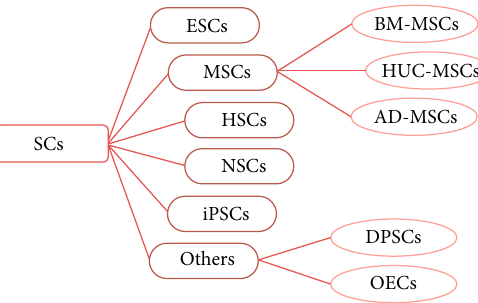
Figure 1: The common stem cell (SC) types for the treatment of spinal cord injury (SCI), including embryonic stem cells (ESCs), mesenchymal stem cells (MSCs), hematopoietic stem cells (HSCs), neural stem cells (NSCs), induced pluripotent stem cells (iPSCs), dental pulp stem cells (DPSCs), and olfactory ensheathing cells (OECs). MSCs consist of bone marrow mesenchymal stem cells (BM-MSCs), human umbilical cord-mesenchymal stem cells (HUC-MSCs), and adipose-derived mesenchymal stem cells (AD-